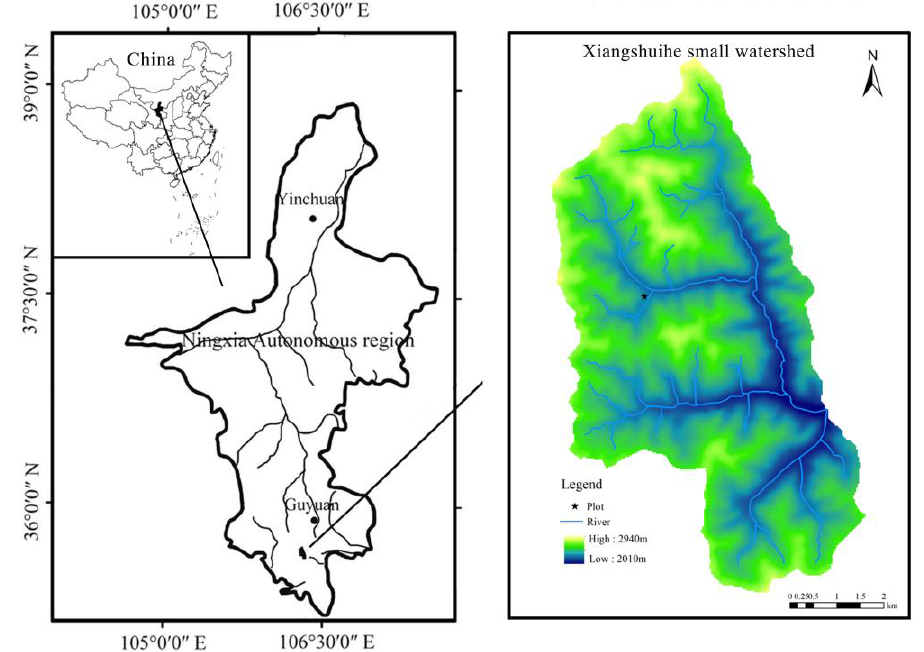
Figure 1. Xiangshuihe small watershed and study plot location. Table 1. Stand characteristics and soil physical properties of the 0–60 cm soil layer of the study plot. Stand Density Canopy (stems ha − 1 )